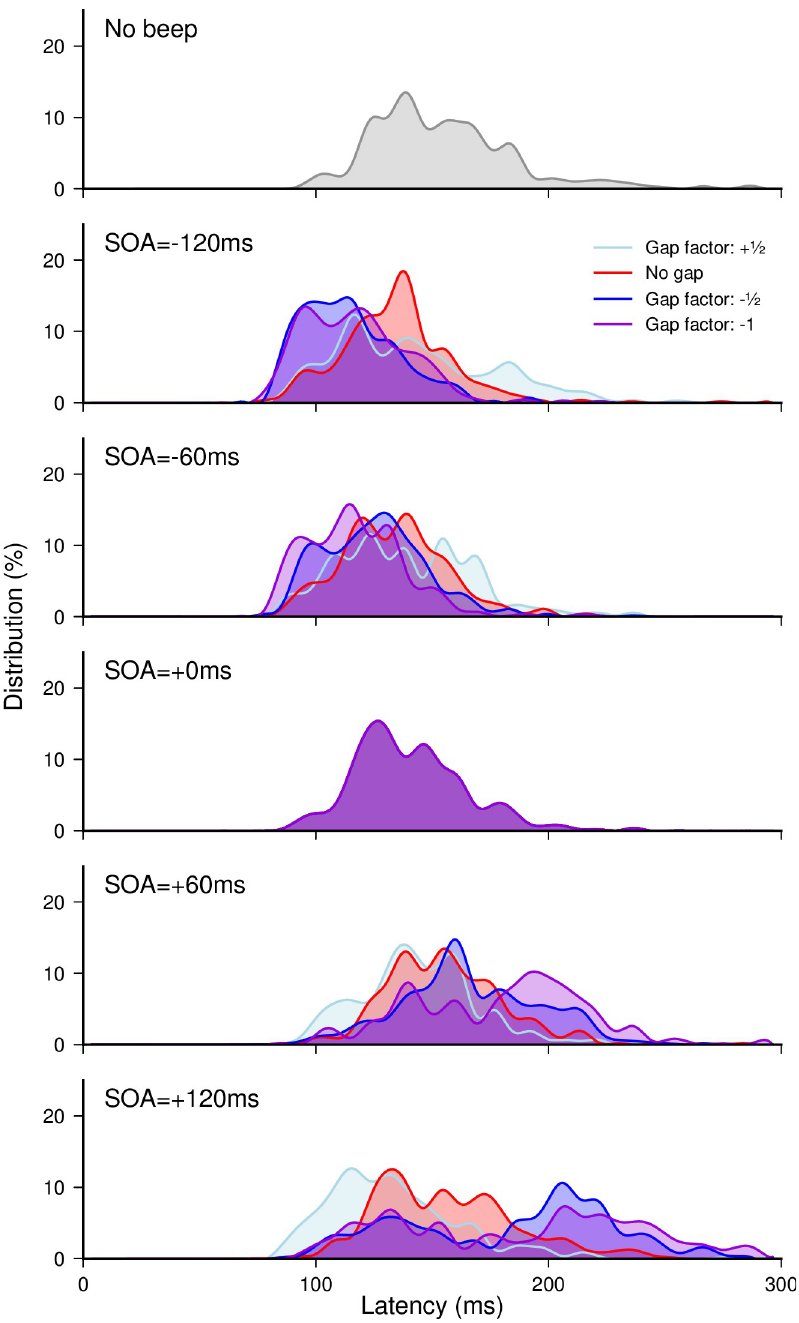
Fig 7. Experiment 2. Saccade latency distributions. Distributions for the No beep condition and for the different Gap factor conditions plotted for each SOA, with data pooled from all participants.